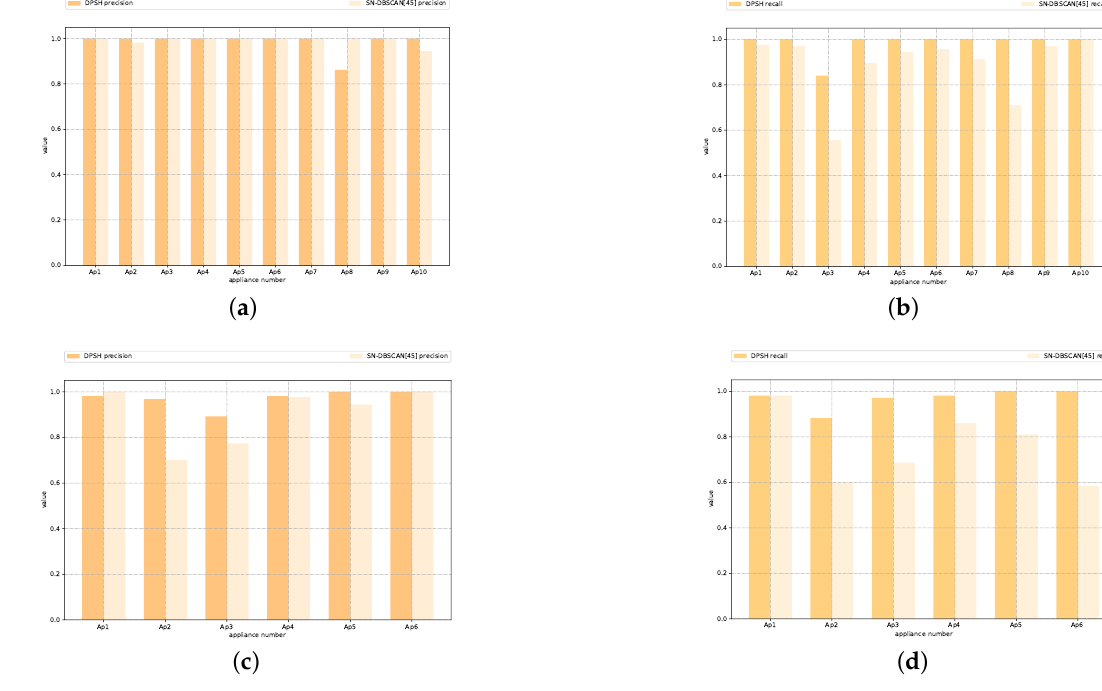
Figure 7. The Precision and Recall for DPSH and SN-DBSCAN algorithm on two datasets. ( a ) The Precision on REDD dataset. ( b ) The Recall on REDD dataset. ( c ) The Precision on PLAID dataset. ( d ) The Recall on PLAID